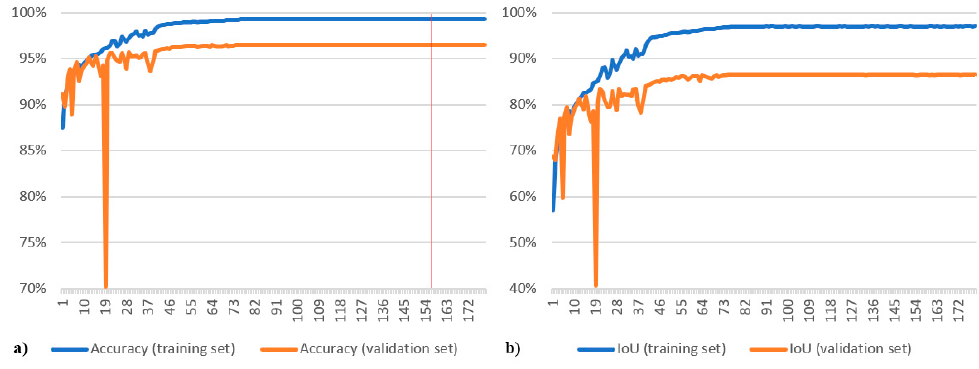
Figure 11. Accuracy ( a ) and IoU ( b ) metrics for the LinkNet model.